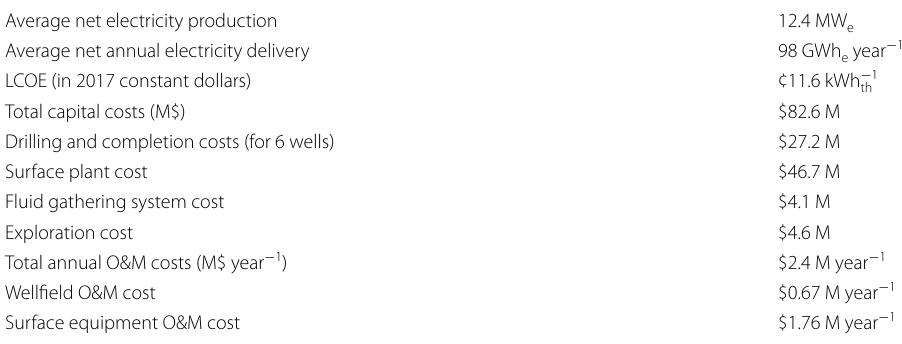
Table 4 GEOPHIRES output results for example simulation 2 Average net electricity